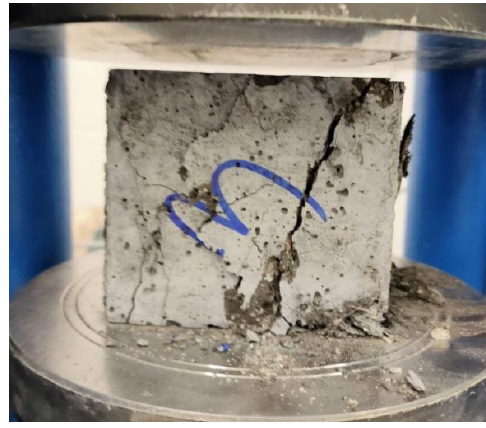
Figure 12. Compressive Strength Workability in Different Curing Periods.